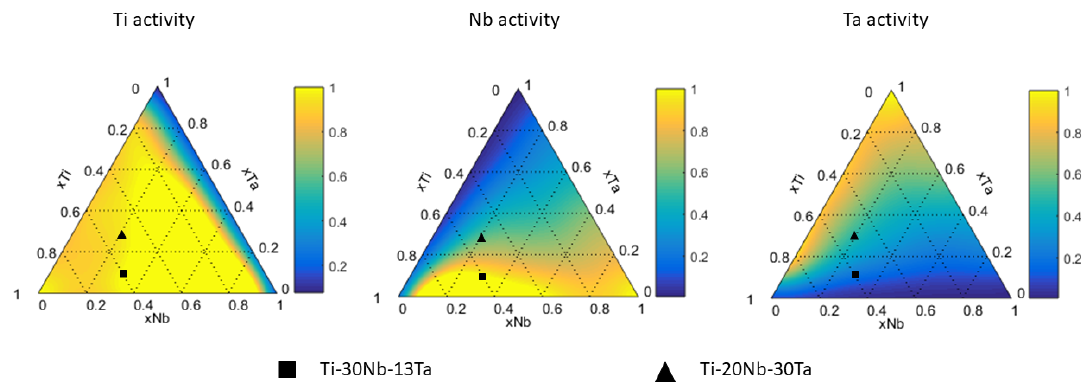
Figure 7. Activity changes as a function of composition for the formation of a solid solution in the Ti ‐ Nb ‐ Ta ternary systems at 298 K.